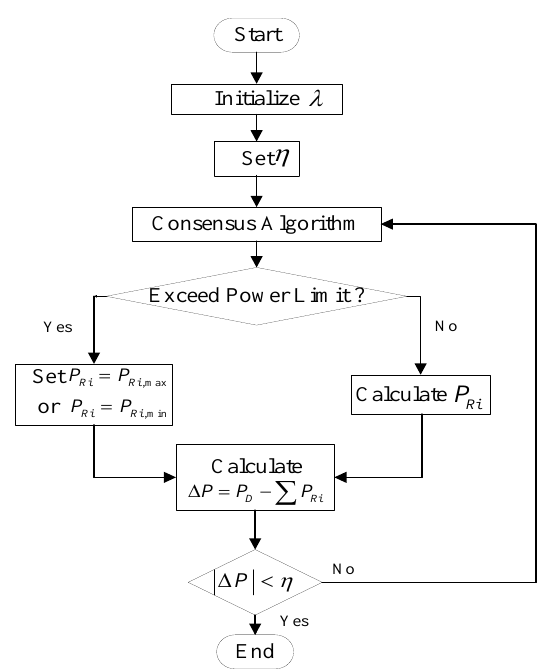
Figure 2. Flowchart of incremental cost consensus (ICC) algorithm.